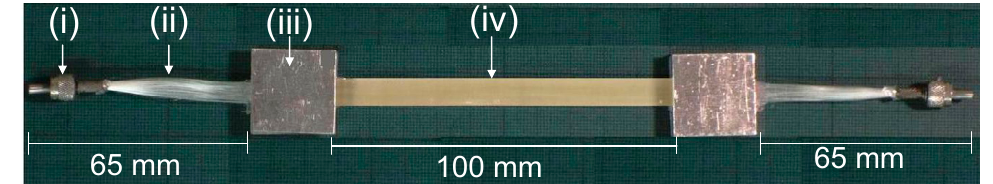
Figure 3. Photograph of a self-sensing composite with SMA connectors and end-tabs: (i) SMA connector; (ii) un-impregnated section of the SDOF bundle; (iii) end-tab; and (iv) void-free composite.